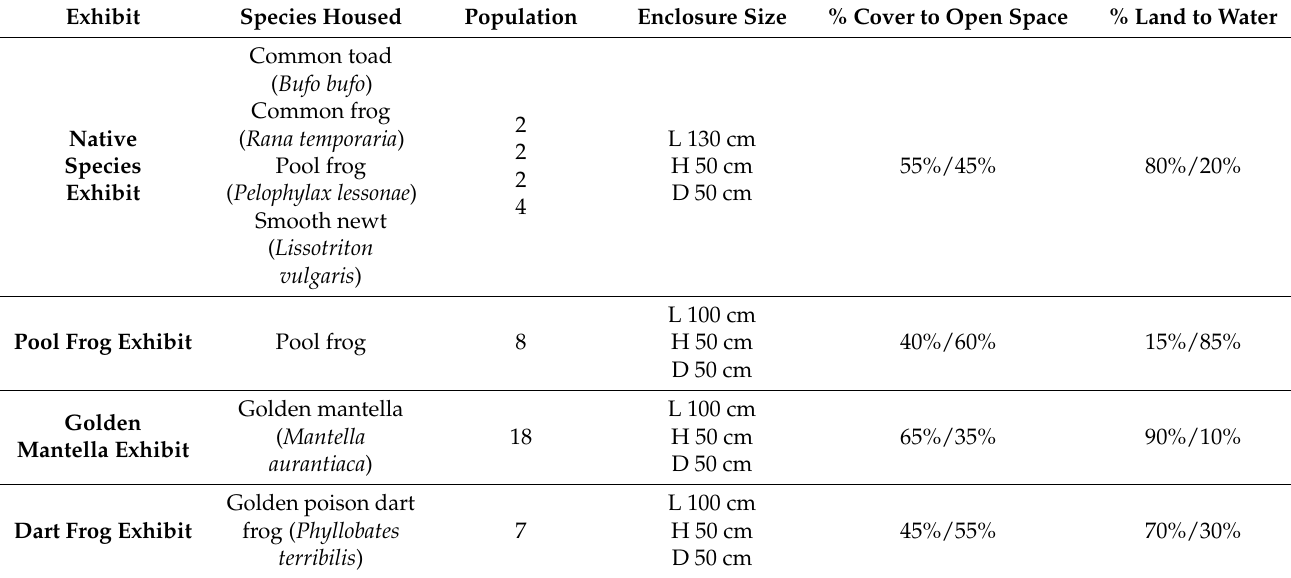
Table 1. Sample populations and housing details of amphibian observed in this